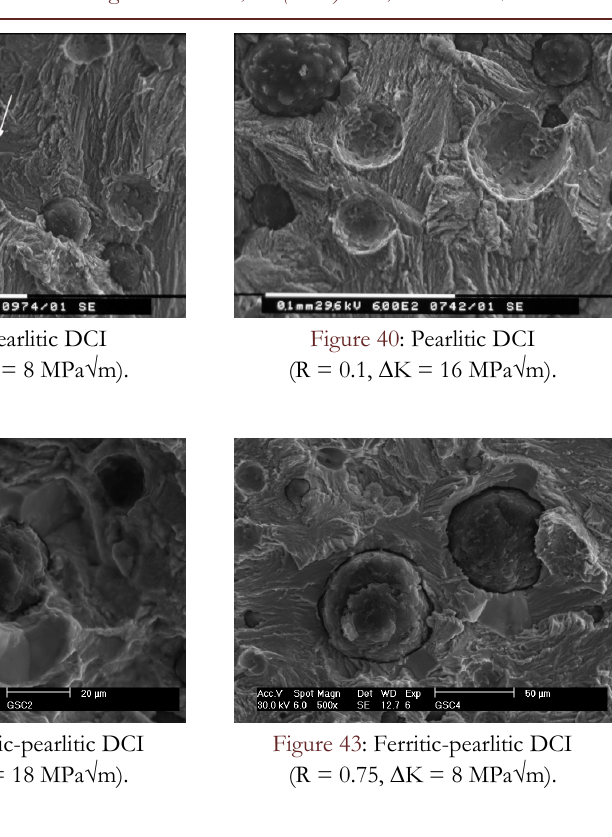
Figura 46: Ferritic-pearlitic DCI (annealed pearlitic DCI) (R = 0.1,  K = 12 MPa √ m).